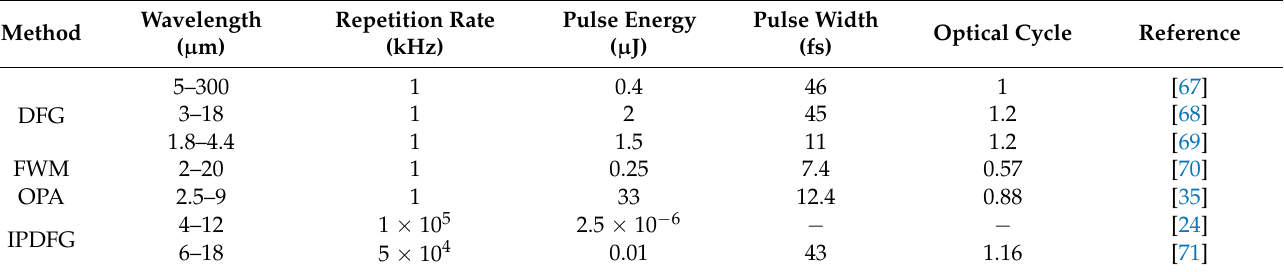
Table 6. Parameters of single- or sub-cycle